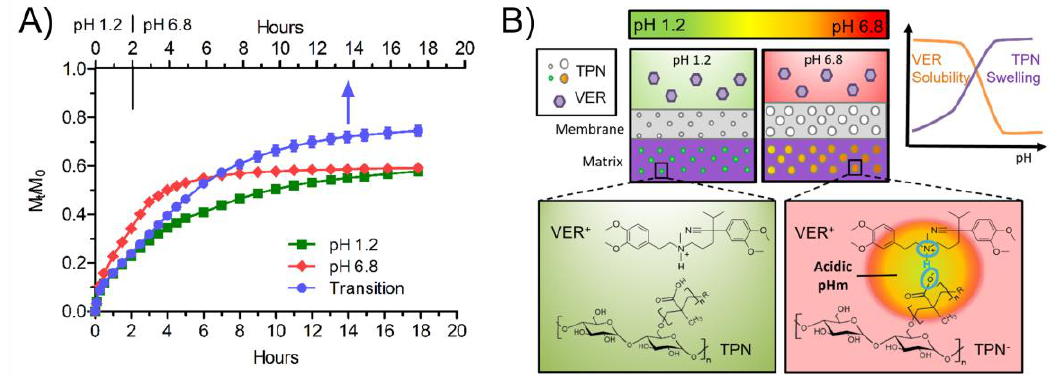
Figure 8. ( A ) Dissolution profiles of TPN bilayer-coated Beads at 19% weight gain, 1:2 VER:TPN ratio, in various pH conditions over full dissolution duration. ( B ) Proposed mechanism of pH m and permeability modulation using TPN to achieve pH transition-independent controlled release from bilayer-coated beads. The combination of lowered pH m generated within the inner matrix and increased permeability of the outer membrane at pH 6.8 enabled pH-independent release over a prolonged duration.